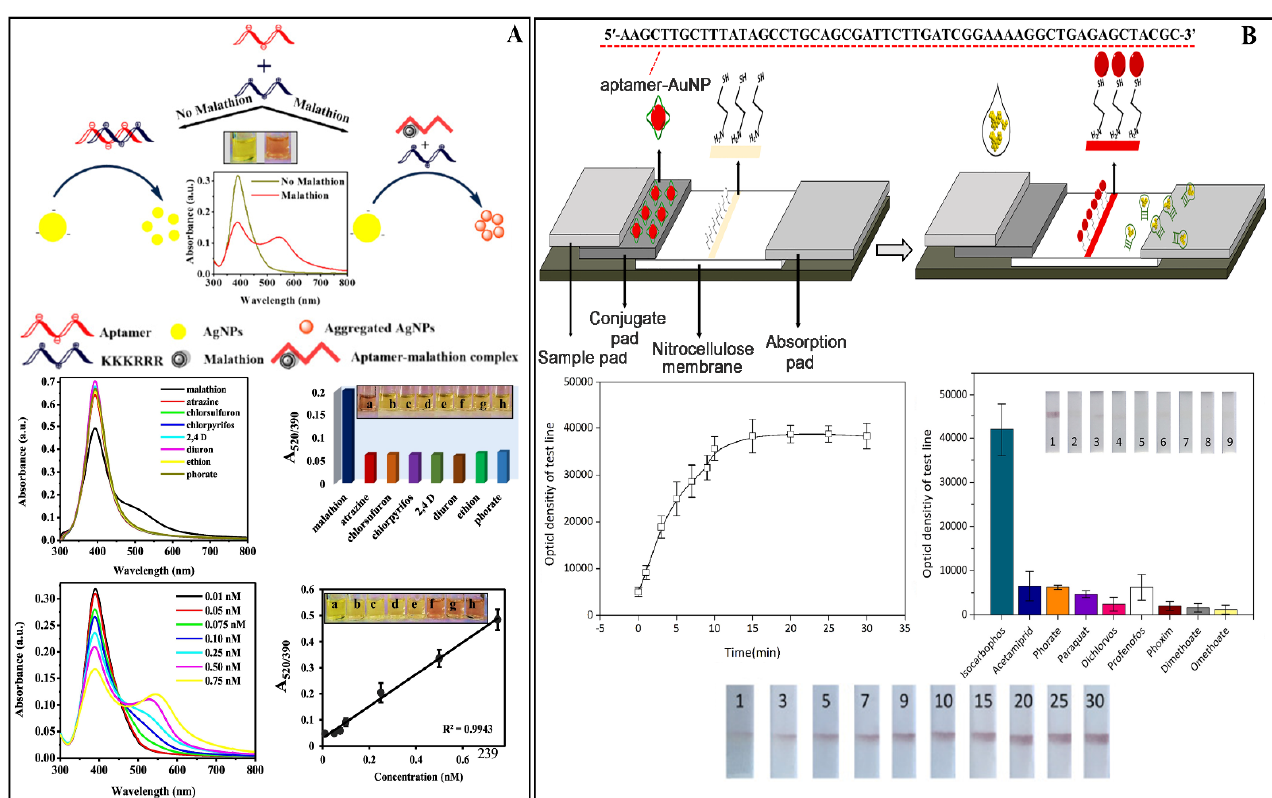
Figure 10. ( A ) Schematic representation of the detection strategy for malathion by employing optical properties of silver nanoparticles. Evaluation of the selectivity of the biosensor for the detection of malathion evaluated with other pesticides and sensitivity through the analytical curves constructed.